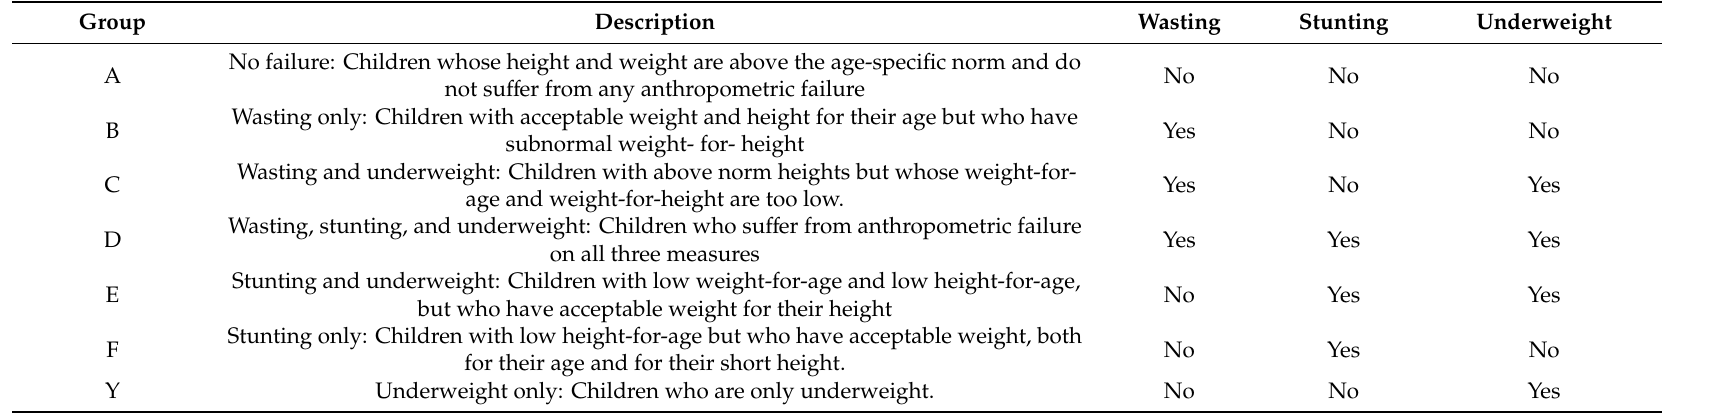
Table A1. Anthropometric failure groups among children under five.